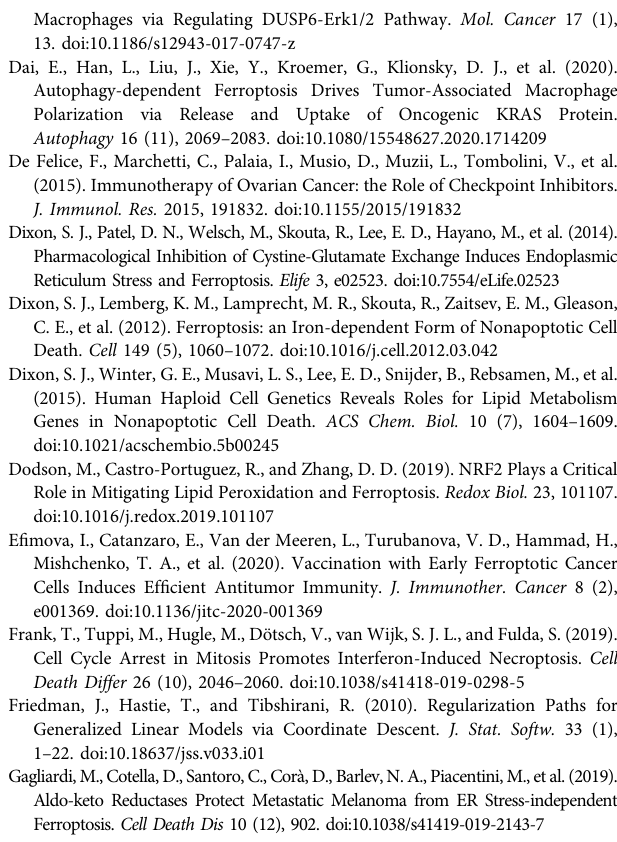
Supplementary Table S3 | The detailed results of GSEA(GO_BP). Supplementary Table S4 | The detailed results of GSEA(GO_CC). Supplementary Table S5 | The detailed results of GSEA(GO_MF). Supplementary Table S6 | The detailed results of GSEA(KEGG